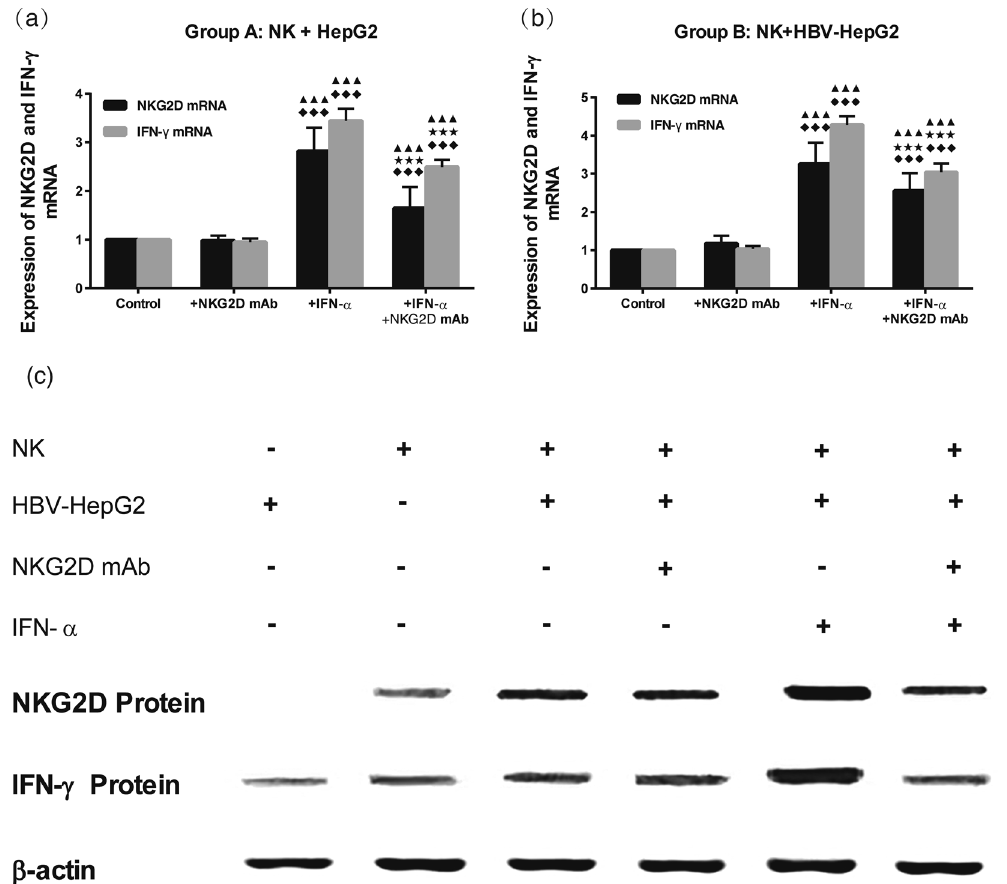
Figure 4. Analysis of NKG2D and IFN- γ mRNA levels in co-cultured cells (NK + HepG2/HBV-HepG2) of Group A ( a , NK + HepG2) and Group B ( b , NK + HBV-HepG2). Nemenyi test following Kruskal-Wallis H test were used for comparing mRNA expressions of NKG2D and IFN- γ between two compared groups. Compared with Control group (NK + HepG2 or NK + HBV-HepG2), ◆◆◆ P < 0.01; Compared with Control + NKG2D mAb group, ★★★ P < 0.01; Compared with Control + IFN- α group, ▲▲▲ P < 0.01; Analysis of the levels of NKG2D and IFN- γ protein in different groups ( c ). The density of NKG2D and IFN- γ protein was the highest in group of NK + HBV-HepG2 + IFN- α , followed by group of NK + HBV-HepG2 + IFN- α + NKG2DmAb and group of NK + HBV-HepG2 +